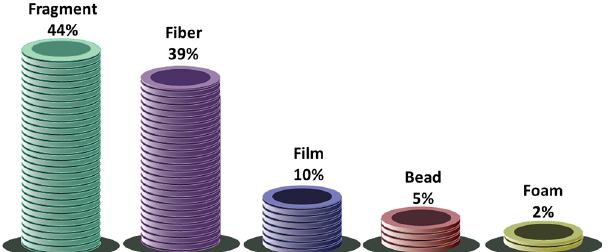
Fig. 1 Morphology of MPs detected in biosolids. Cylindrical MPs with a high length to diameter ratio were identi fi ed as fi bers. Sheet-like MPs with low thickness and high surface area were identi fi ed as fi lms. Spherical and granular MPs were identi fi ed as beads. Sponge-like mass structures were identi fi ed as foams. Any other MPs with irregular shapes were identi fi ed as